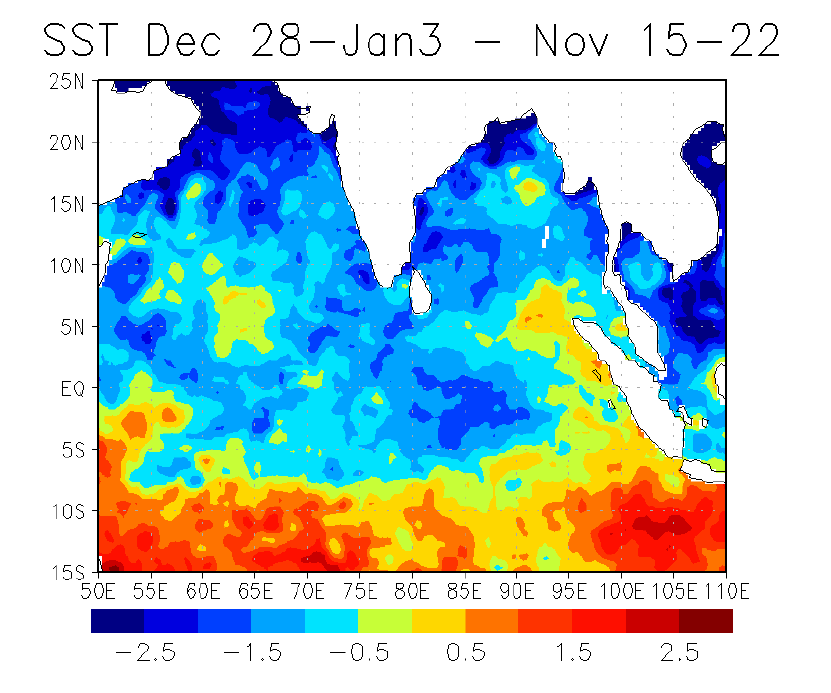
Figure 8. Average SST (°C) during 28 December 2011–3 January 2012 minus that during 15–22 November 2011 based on the SST analysis